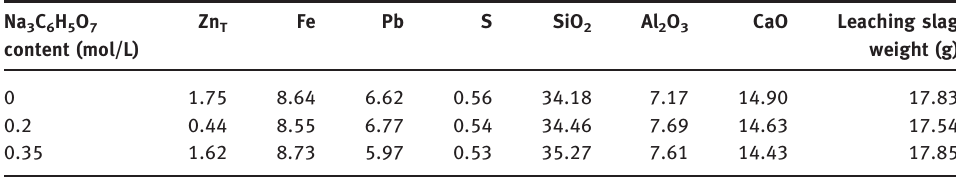
Table 3: Main chemical composition of leaching slags (mass fraction,